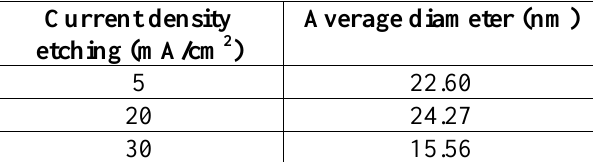
Table 1: The value of average pore diameter.